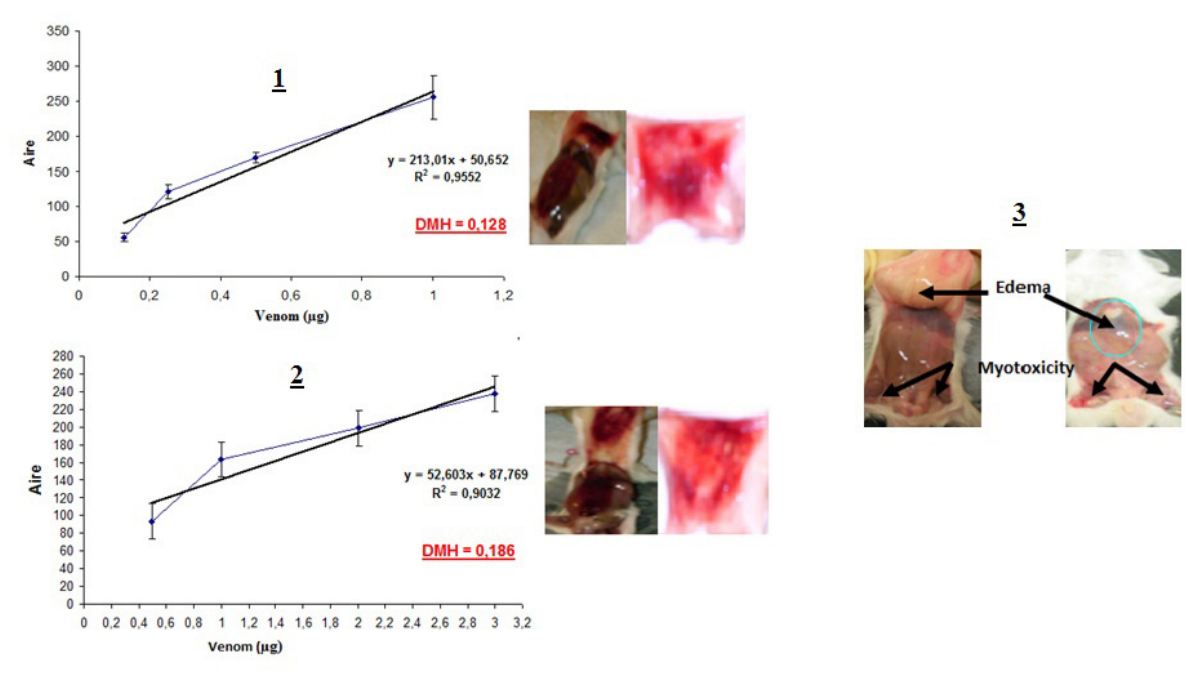
Figure 3. Minimum hemorrhagic dose (MHD) of (1) Macrovipera mauritanica ; (2) Cerastes cerastes and (3) Naja haje